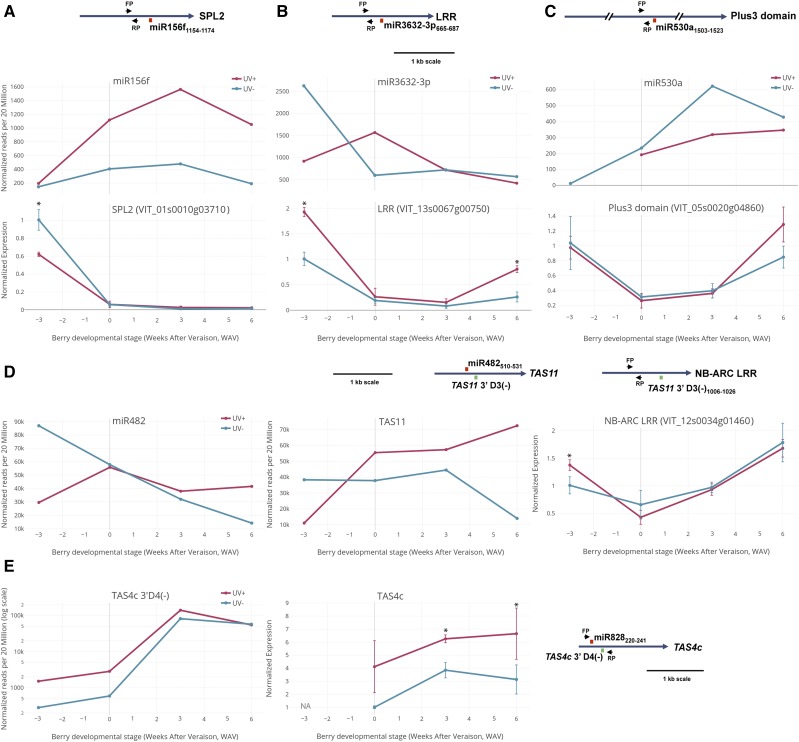
Functional validation of differentially expressed miRNA activities under high-fluence UV-B by qRT-PCR of target genes. Upper Panel A-C, left panel D: miRNA/siRNA deep-sequencing profiles at different berry developmental stages (weeks after veraison, WAV) under high-fluence UV-B in greenhouse. Lower Panels A-C, right panel D: miRNA target gene expression profile at different berry developmental stages under high-fluence UV-B. A) miR156f and its target Squamosa promoter binding protein-like 2 (SPL2) expression profile. B) miR3632-3p and its target Leucine-rich repeat protein (LRR) expression profile. C) miR530a and its target Plus3 domain protein expression profile. D) miR482 expression profile (left panel). Middle Panel: TAS11 3′ D3(-) trans acting siRNA expression profile triggered by miR482. Right Panel: Expression profile of NB-ARC LRR VIT_12s0034g01460 targeted by TAS11 3′ D3(-) tasiRNA. E) TAS4c 3′ D4(-) trans acting siRNA expression profile (left panel) and the expression profile of TAS4c undiced primary transcript (right panel; “NA”: not available. Test samples were normalized to 0 WAV minus UV-B [set to unity]). Error bars are s.d. Asterisks (*) denote significant differences based on analysis of variance (n = 3 biological replicates) and comparisons using the Tukey-Kramer honestly significance test (HSD; P < 0.05). Insets, A-E: Target-miRNA/siRNA binding positions (mRNA nucleotide coordinates) and primer binding sites (arrows) are depicted to scale. Target:miRNA binding depicted in Red; Target:tasiRNA binding depicted in Green.